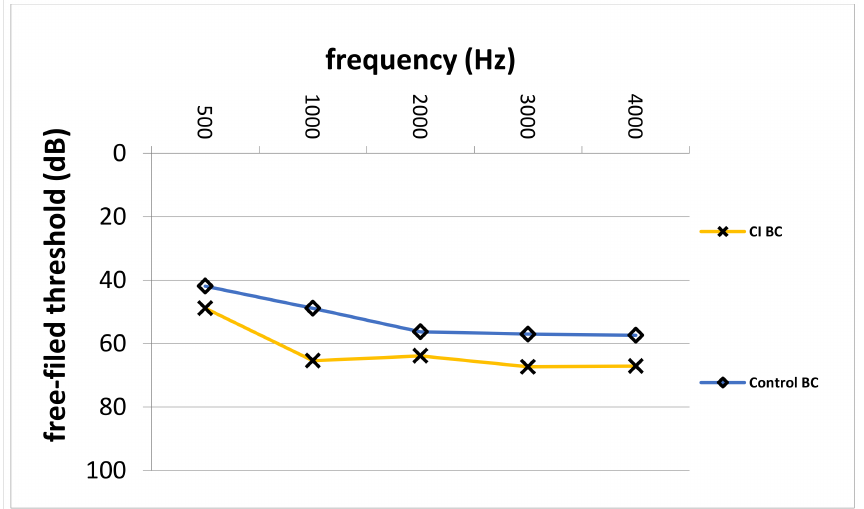
Figure 5. Average pre-VSB BC thresholds across frequencies for the CI and control group. BC, bone- conduction; Hz, Hertz; dB,Decibel; CI,cochlearimplant; Control, controlgroup;